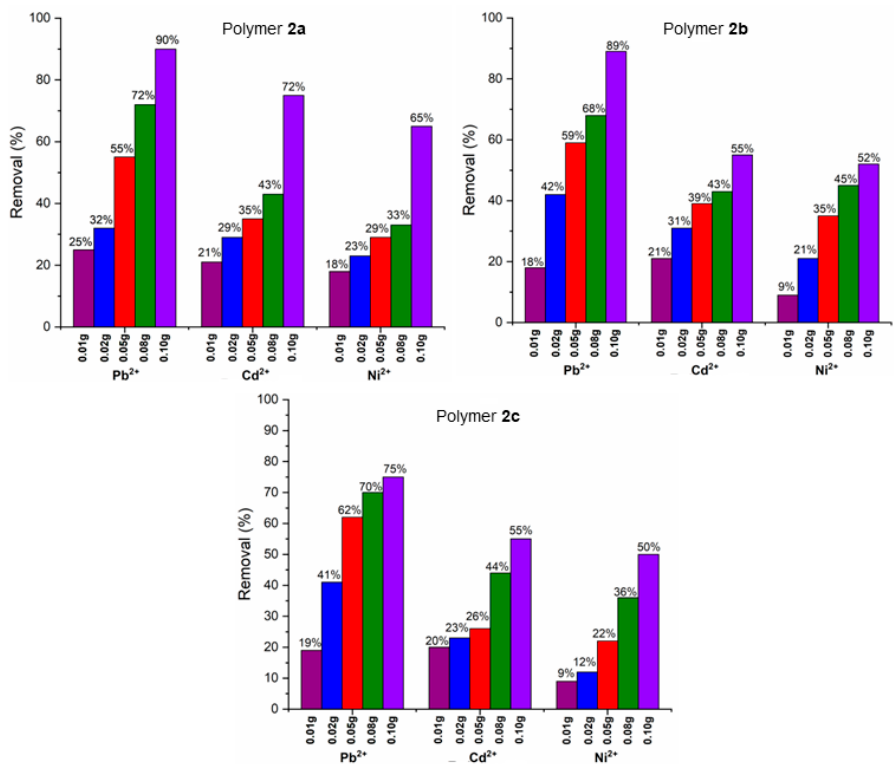
Figure 9. Percent removal of heavy metal ions versus the amount of polymer.